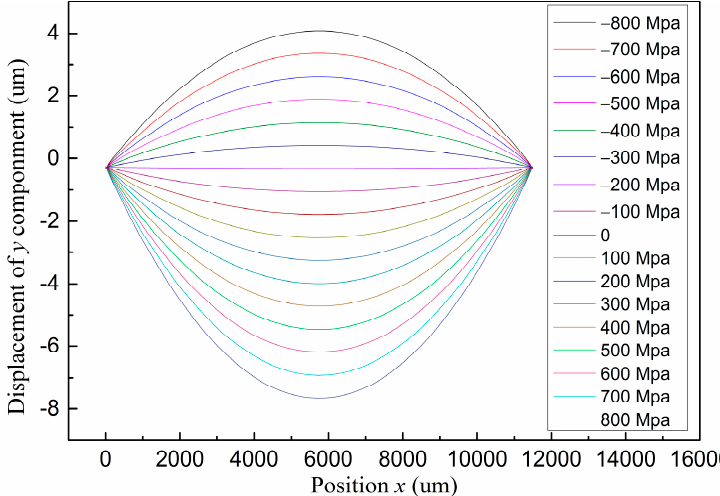
Figure 4. Displacement profiles of y component of the multilayer thin films under intrinsic stresses of SiN x film ranging from − 800 MPa compressive stress to 800 MPa tensile stress, with stress increment of 100 MPa.